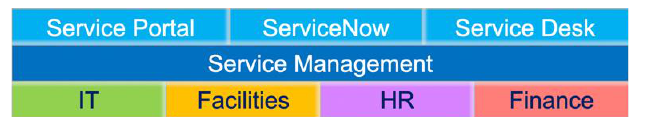
Fig. 2. Common Service Catalogue and single process set across CERN, and single point of contact